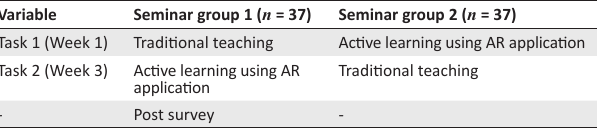
TABLE 1: A post-intervention crossover study design ( n =